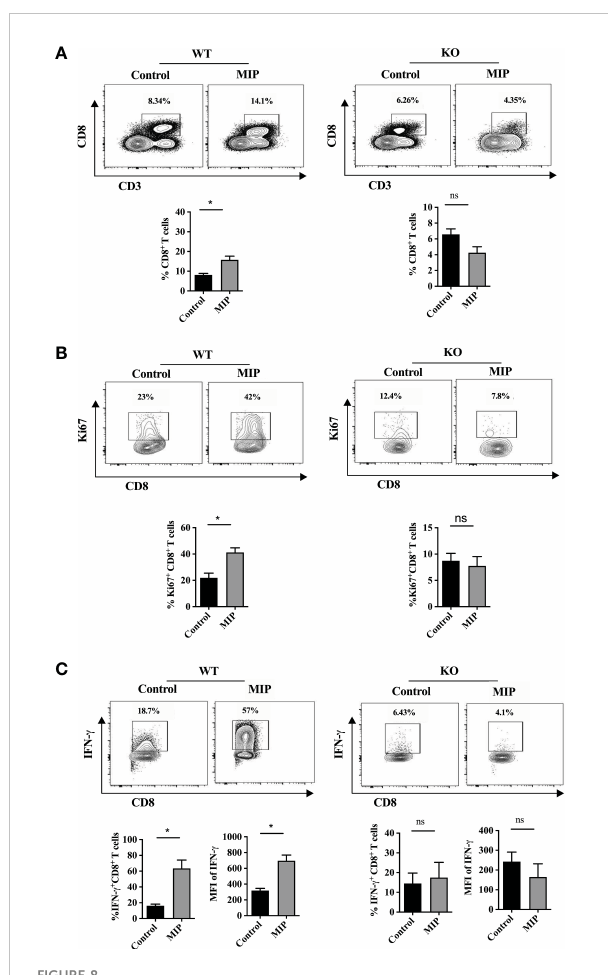
FIGURE 8 Importance of type 1 IFN in MIP mediated remodulation of percent frequency and effector function of intratumoral CD8 + T cells: (A) Percent frequency of intratumoral CD8 + T cells was determined in wild type and IFNR1 -/- tumor bearing mice treated with or without MIP. (B) Effect of MIP immunotherapy on proliferation of tumor-in fi ltrating CD8 + T cells in wild type and IFNR1 -/- mice. (C) In wildtype and IFNR1 -/- mice, effect of MIP therapy on effector function of intratumoral CD8 T cells was determined in terms of production of IFN- g from CD8 + T cells. Flow cytometry contour plot is shown for one representative mouse per group. The bar graphs represent average of 5 mice per group. The results are expressed as means ± SEM. Statistical analysis was performed using unpaired non-parametric Student ’ s t test (*:p<0.05, ns, non-signi fi cant). Each experiment was repeated two times independent of each